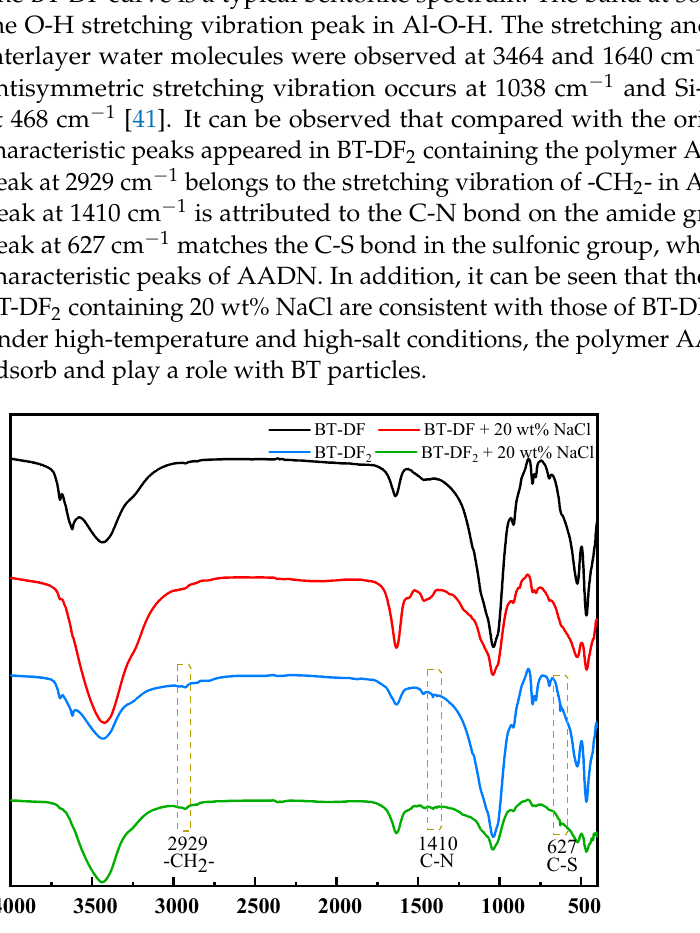
Figure 7. XRD of different BT-DF (after aging at 200 °C for 16 h).